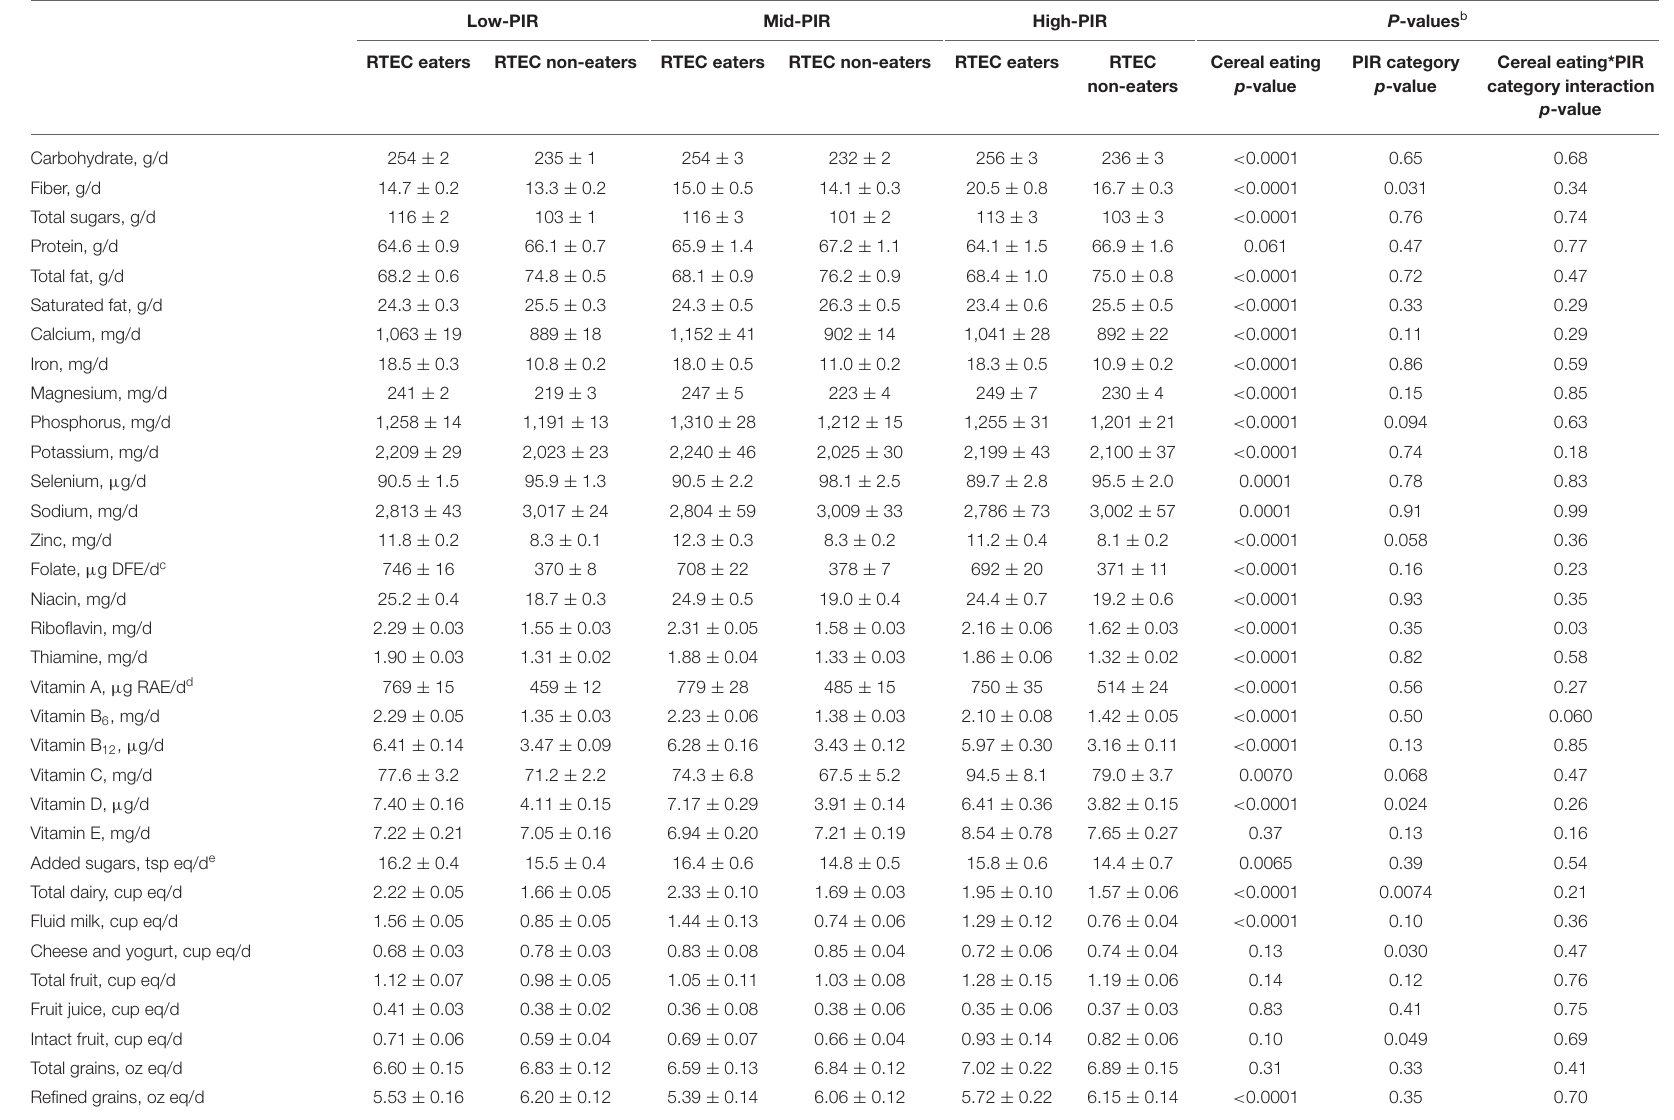
TABLE 2 | Adjusted mean daily nutrient and food group intakes for American children by ready-to-eat cereal consumption and poverty-to-income ratio status, National Health and Nutrition Examination Survey, 2015–2018 a